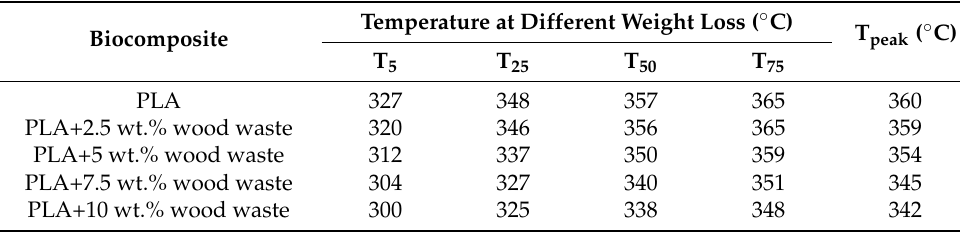
Table 3. TGA and DTG results of wood waste-filled PLA biocomposites.